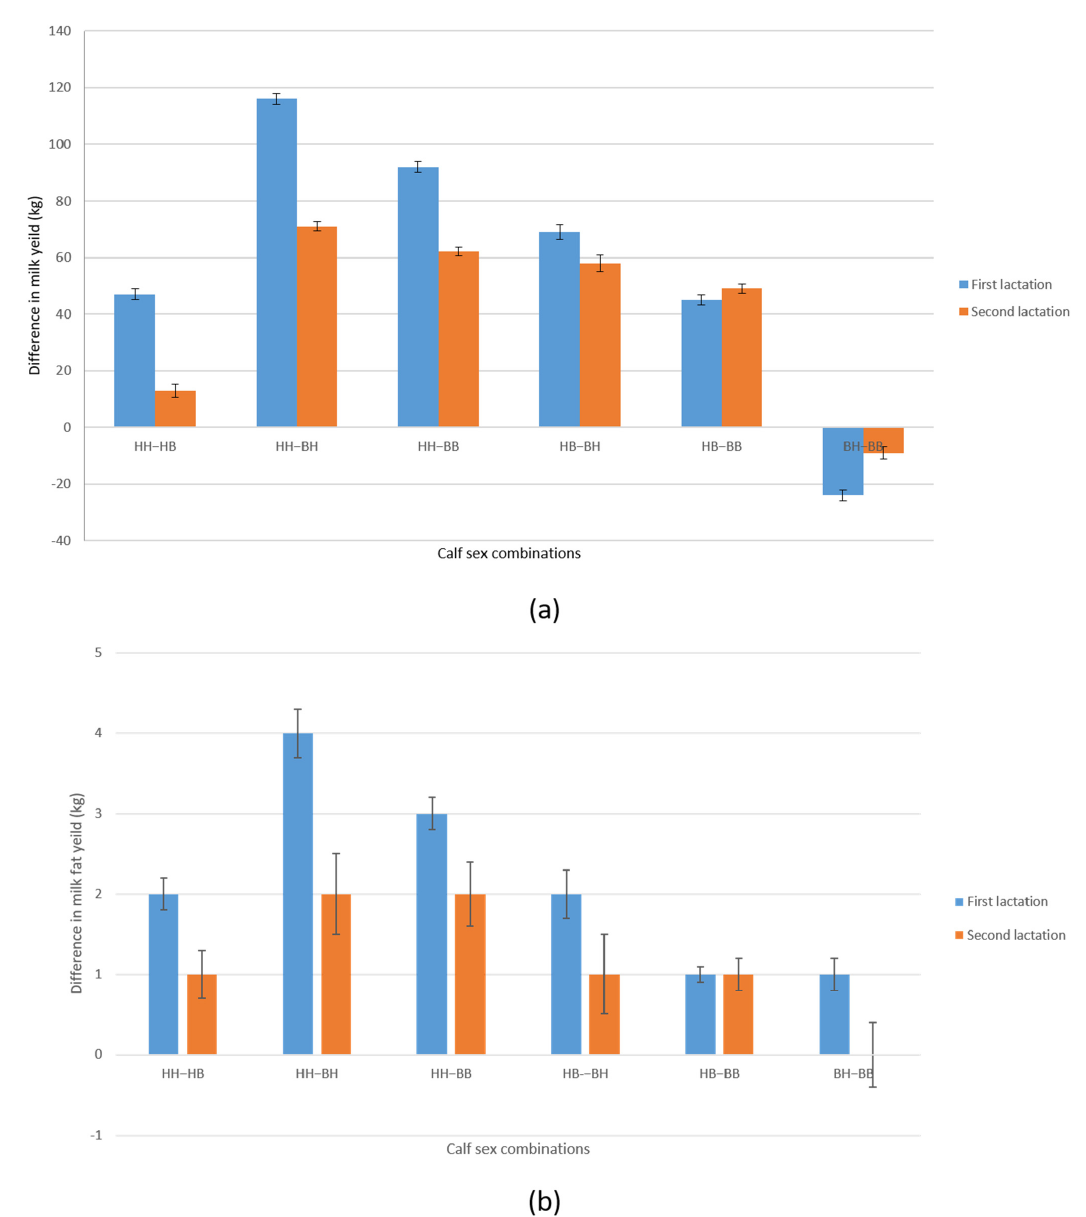
Figure 1. Differences in milk yield ± SE (part ( a )) and milk fat yield ± SE (part ( b )) in first and second standard lactation (305 days) between possible combinations of calf sexes (H = heifer; B = bull) by birth order (HH-HB; HH-BH; HH-BB; HB-BH, BH-BB). Analysis of 15,181 Holstein crossbreed cows produced on farms in the Republic of Serbia in the period from 1985 to 2017 showed that the largest difference in MY in first and second lactation is observed between combinations (HH-BH and HH-BB). As it is known that milk yield and milk fat yield are in high genetic correlation and in milk fat yield in first and second lactation, the largest differences between the same combinations of calf sexes in the order of birth (HH-BH and HH-BB) were recorded. The determined differences between the observed sex combinations were statistically significant ( p < 0.01); SE—standard